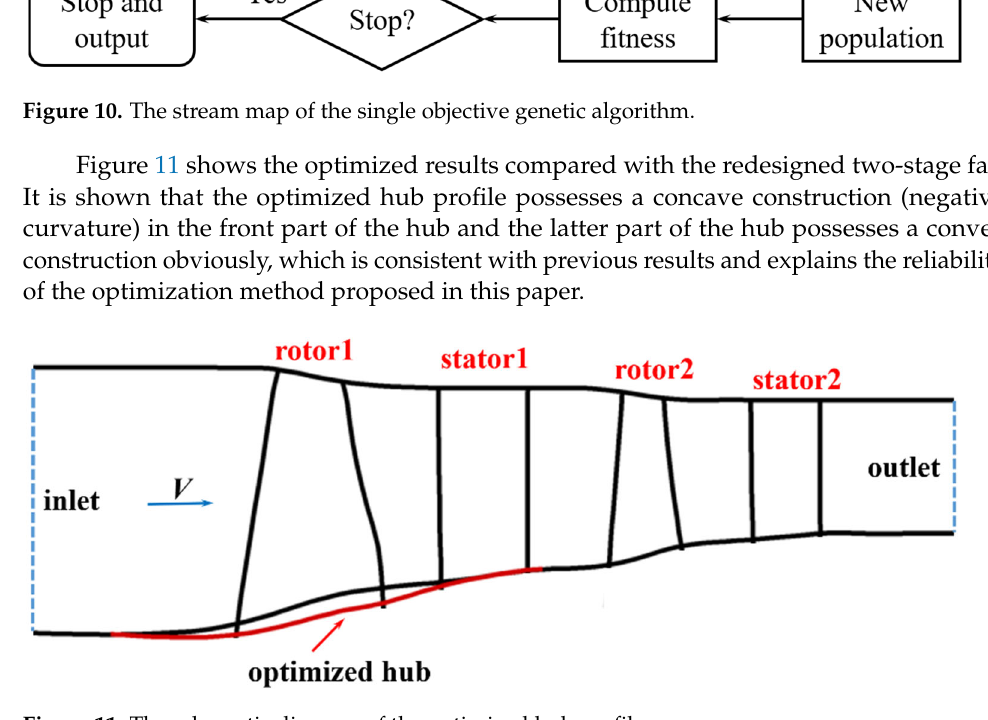
Table 4. The comparison of aerodynamic performance.